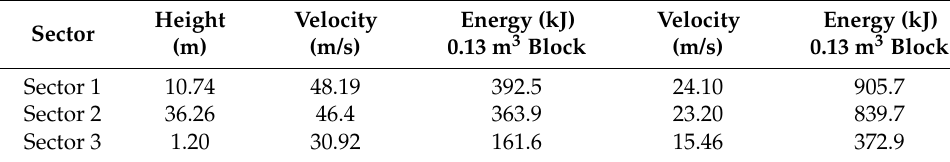
Table 6. Height and velocity (percentile 95%) and kinetic energy—Phase 2.